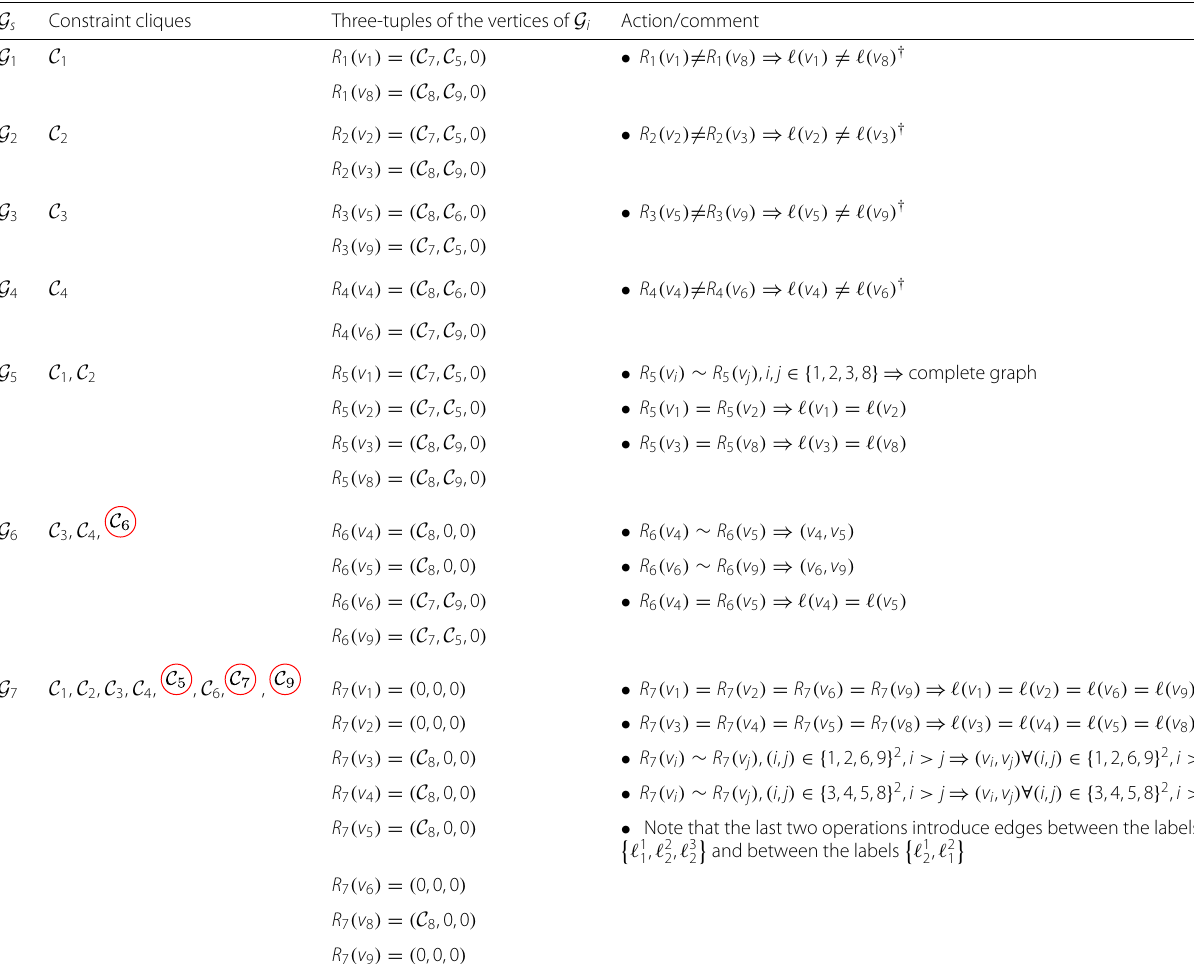
Table 4 Three-tuples used to determine the edges and labels for the example in Fig. 14 G s Constraint cliques Three-tuples of the vertices of